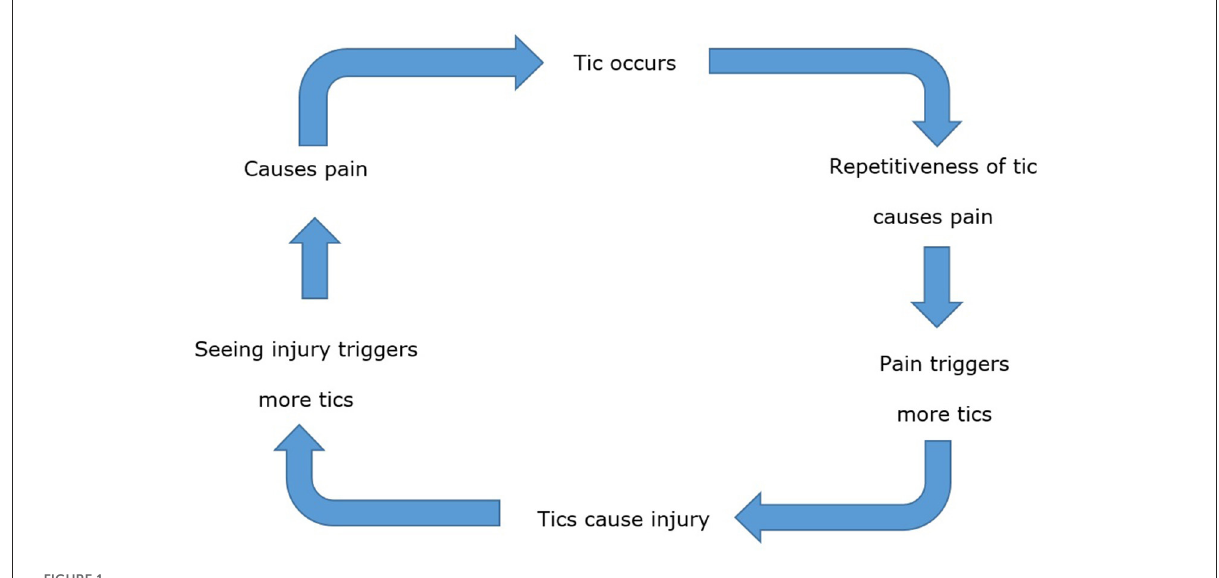
FIGURE1 Theorized diagram of the “Tic-Pain